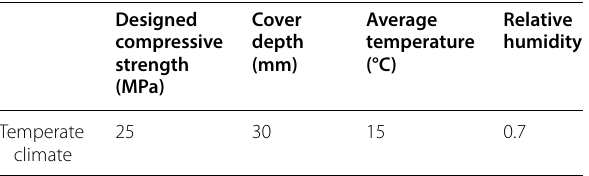
Table 4 Summary of exposure